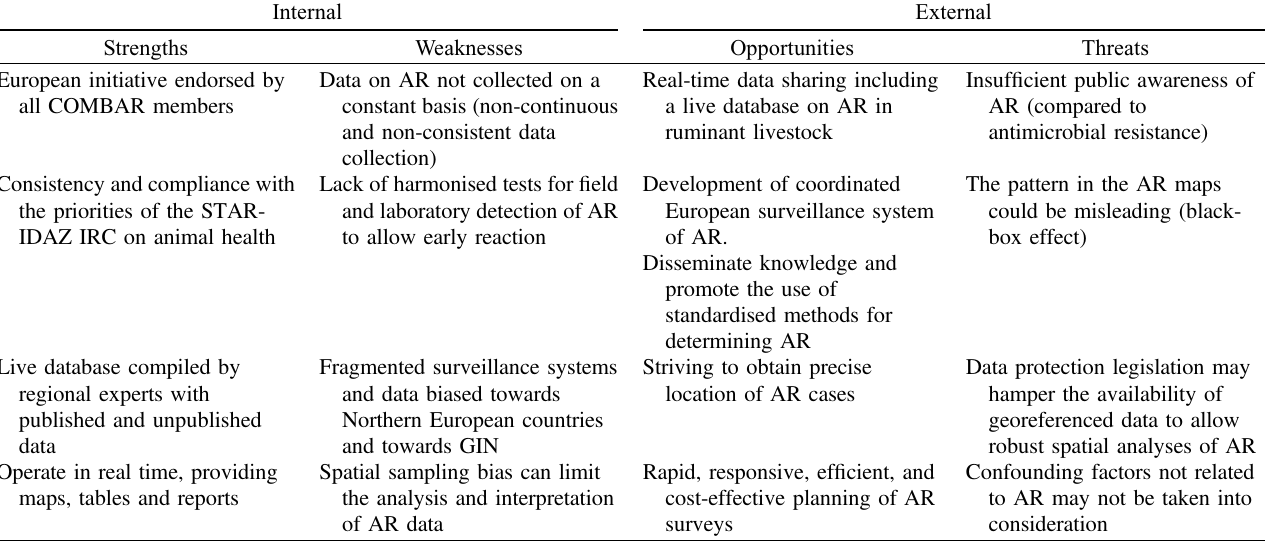
Table 2. SWOT analysis for AR research in Europe. COMBAR = EU COST Action Combating Anthelmintic Resistance in Europe